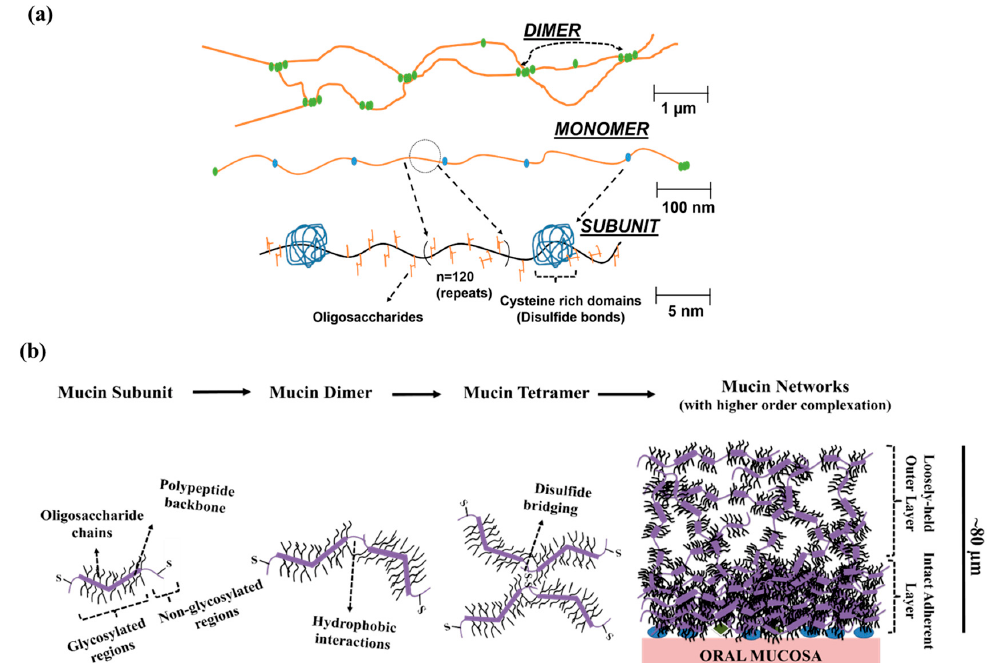
Figure 1. Mucin glycoprotein’s molecular properties, and its network formation ability. ( a ) A simplified scheme shows the composition of mucin glycoproteins, its subunit, monomer, and dimer; ( b ) Progression of higher order complexation of mucin glycoproteins resulting in the formation of a mucin network over oral mucosal surface. This scheme demonstrates the progression of high-order complexation process, which results in formation of mucin aggregates. Mucin aggregates invariably contain two-distinct zones: the more intact adherent mucin layers, and loosely-held (expanded) mucin layers of high free-volume. The illustrated scheme is adapted from References [22–24].